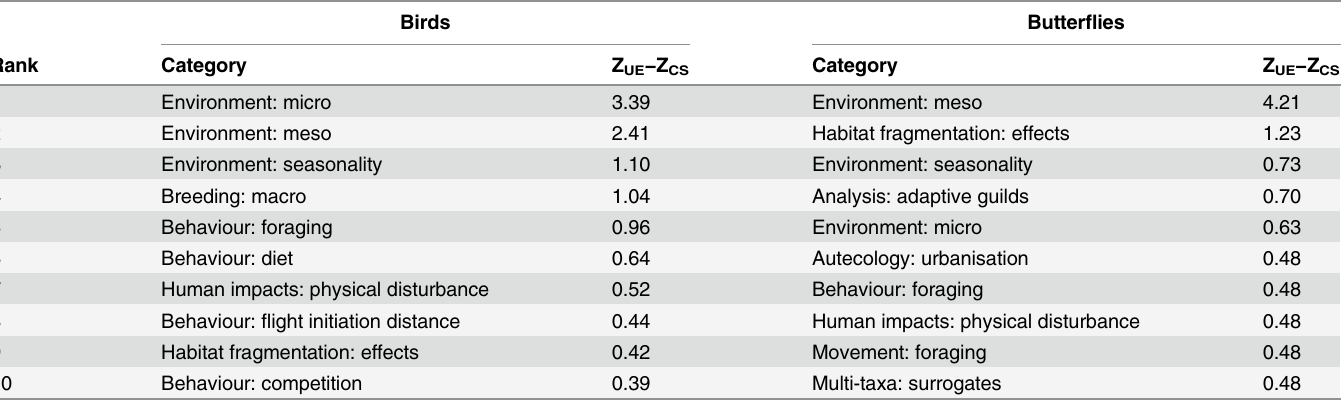
Table 5. Top ten research categories under-represented in the CS compared to UE literature for birds and butterflies, ranked by the difference between z-scores for UE and CS respectively. Birds Butter fl ies Rank